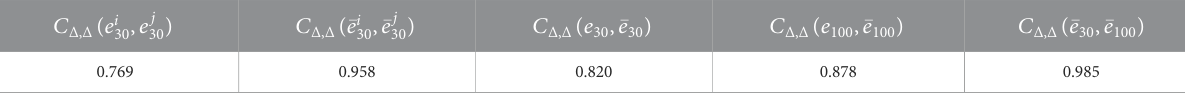
TABLE 4 Pearson ’ s coef fi cients between Δ of different